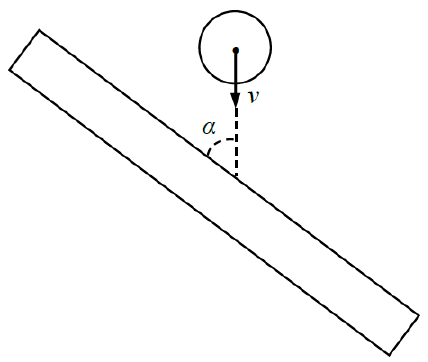
Figure 16. Definition of the impact angle α .